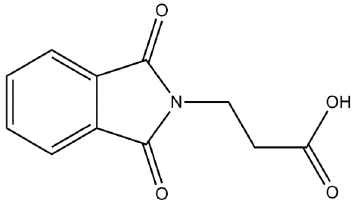
Figure 5. Chemical structure of Product 1 .